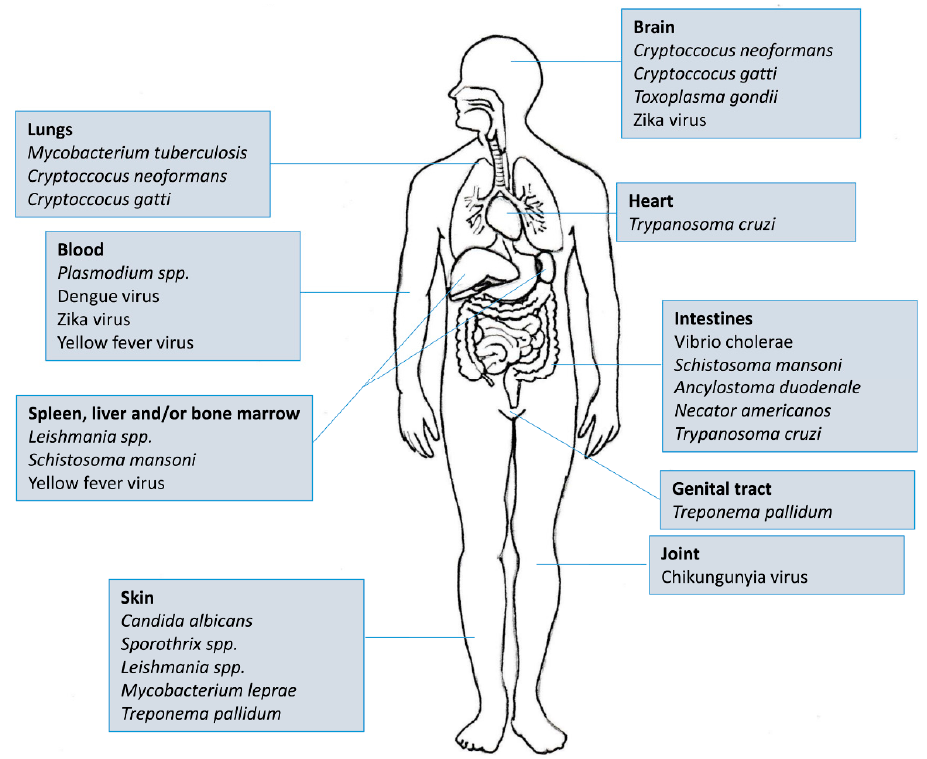
Figure 3. Etiological agents of tropical and/or neglected diseases in relation to major affected areas of